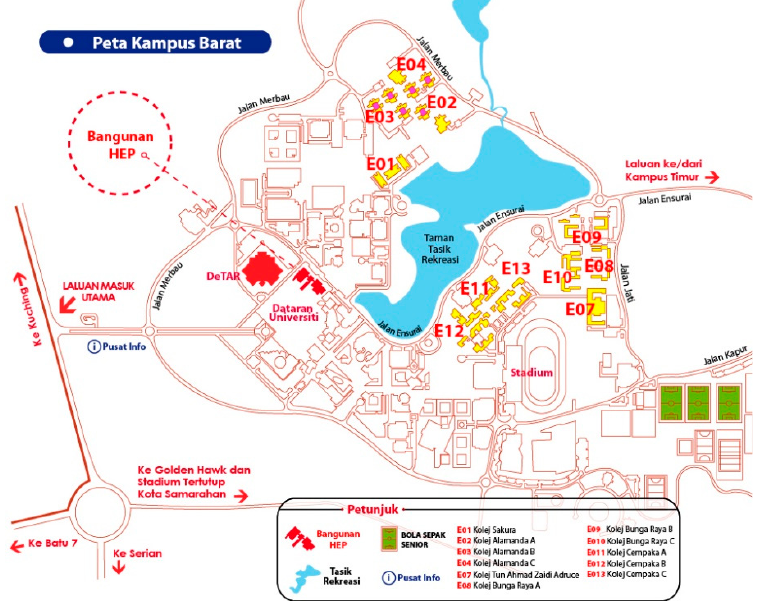
Figure 1. University of Malaya campus map. Table 1. Variables used in this study for analysis.